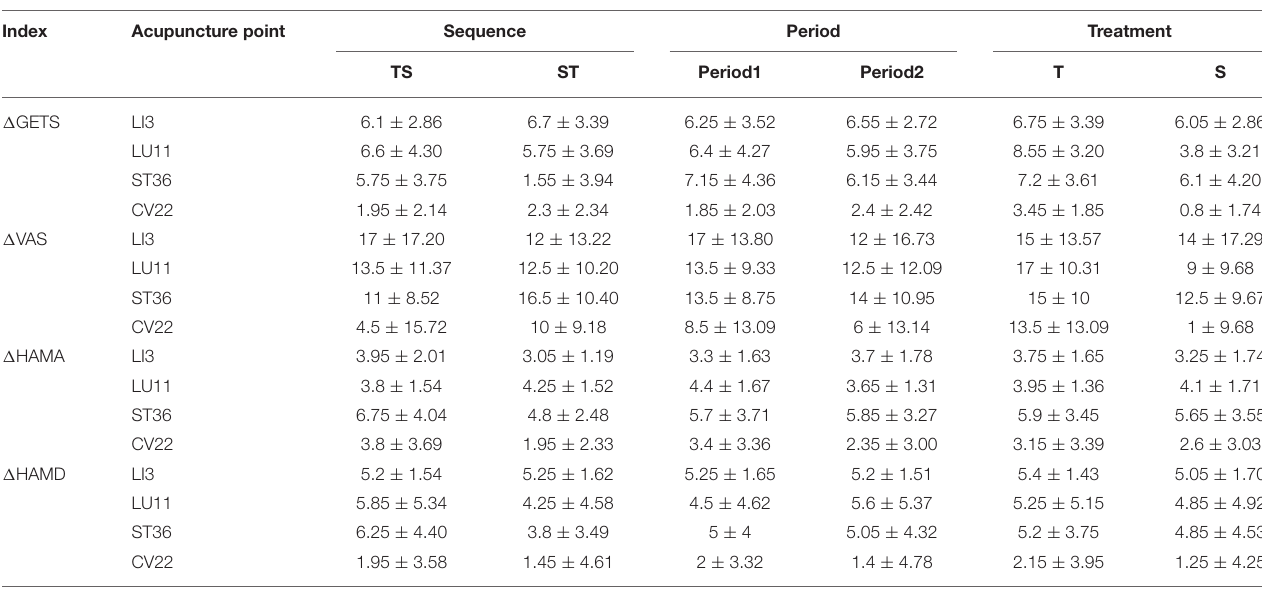
TABLE 2 | Efficacy endpoint of the subjects after